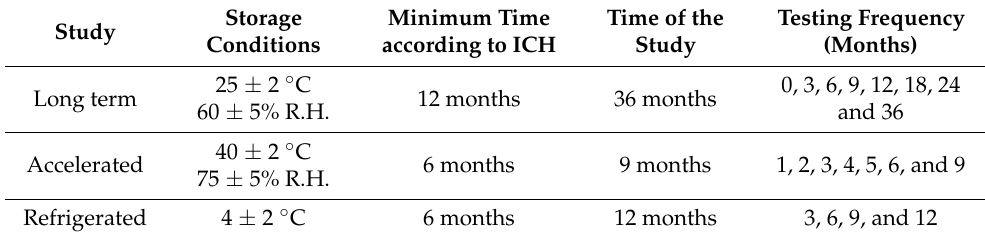
Table 3. Conditions of the stability study.